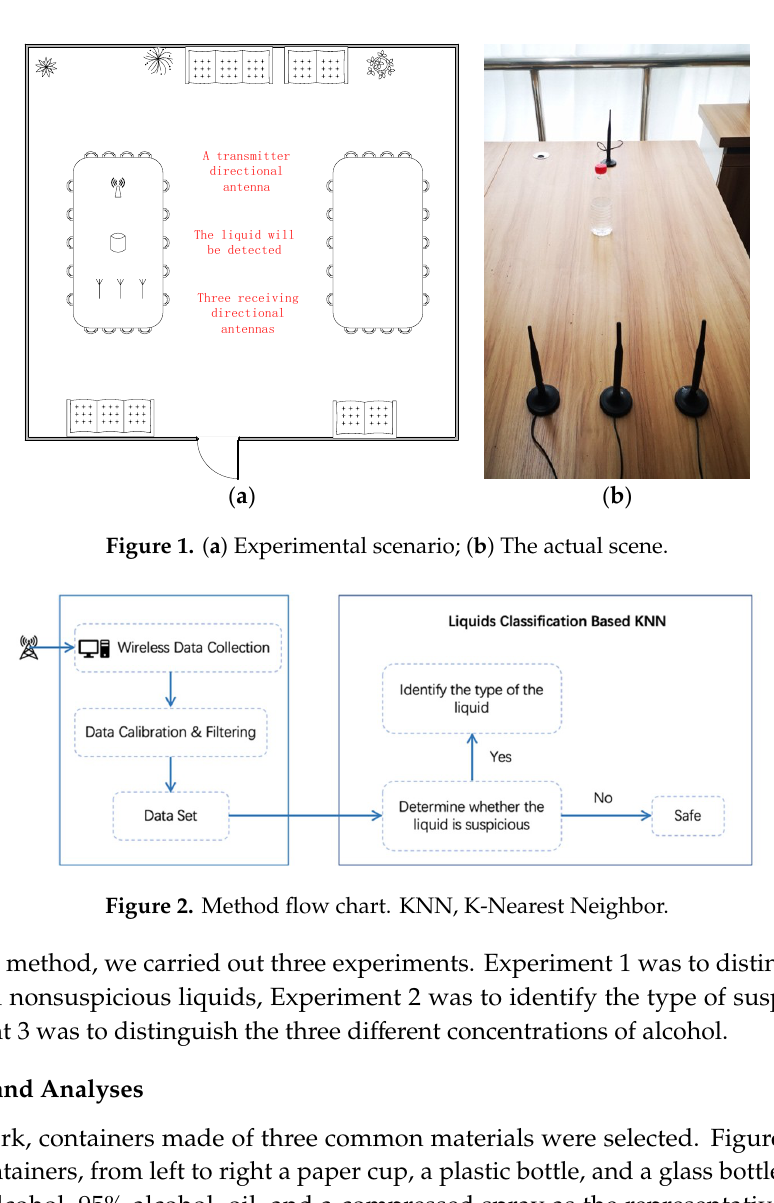
Figure 2. Method flow chart. KNN, K-Nearest Neighbor.